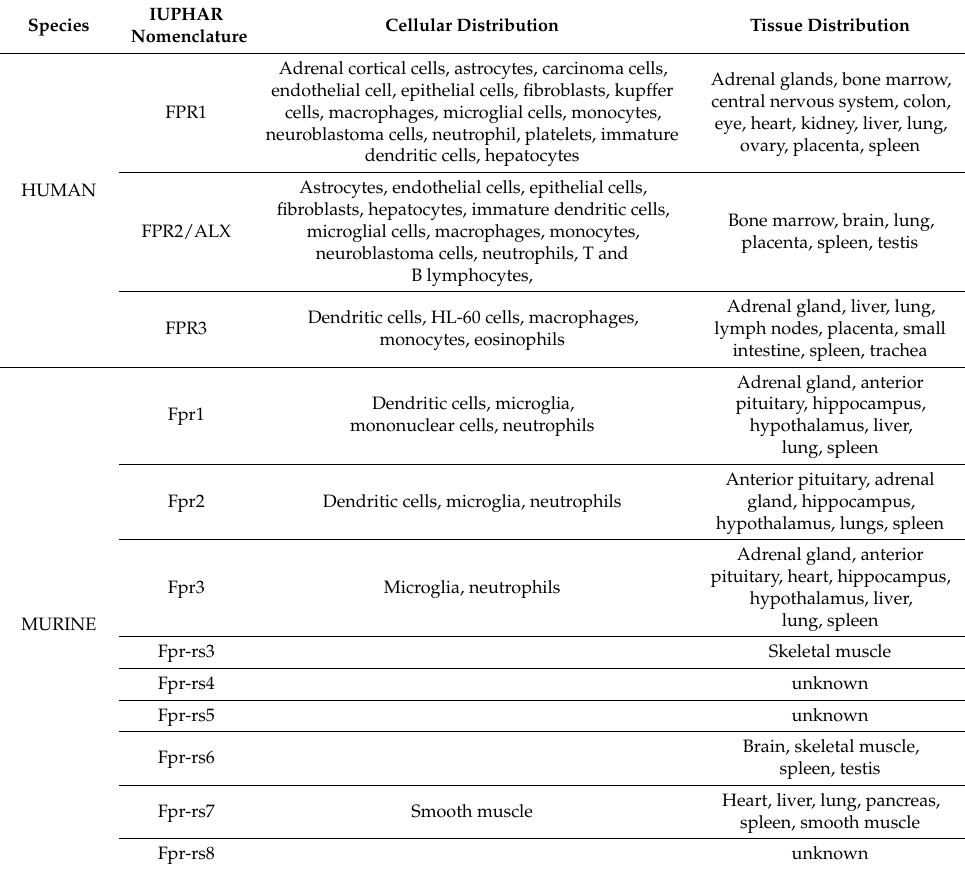
Table 1. FPR nomenclature and cellular and tissue distribution in human and